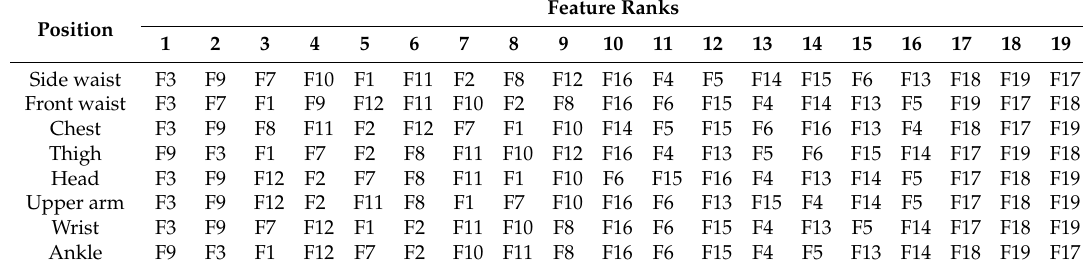
Table 2. The feature rankings obtained from Relief-F on Dataset 1 (DS1).